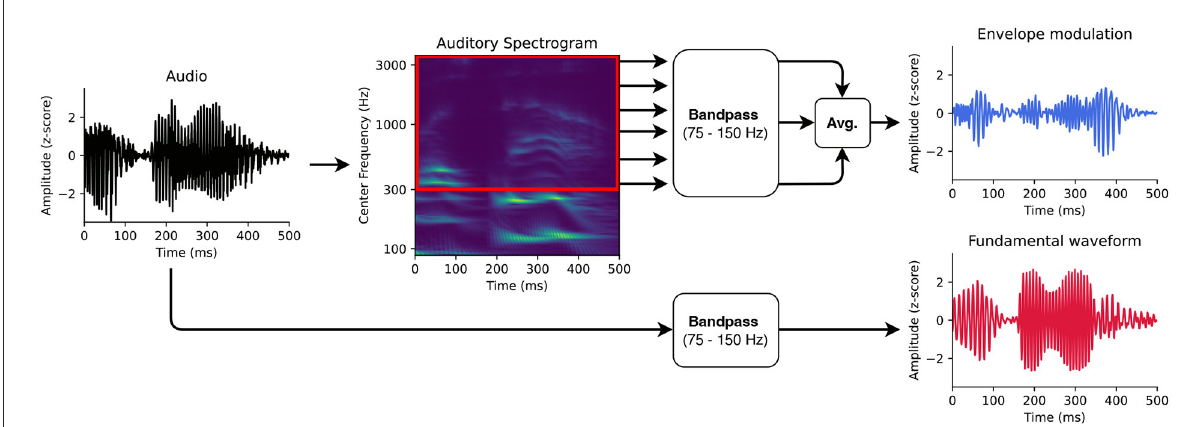
FIGURE1 Auditory features for modeling the neural responses at the fundamental frequency. First, the fundamental waveform (red) was obtained by band-pass filtering the audio signal. Second, the high-frequency modulation of the envelope modulation was computed as well. The audio input was therefore transformed into an auditory spectrogram using a model of the auditory periphery. The frequency bins of the auditory spectrogram above 300 Hz were then filtered in the range of the fundamental frequency. The filtered bins were finally averaged to obtain the envelope modulation